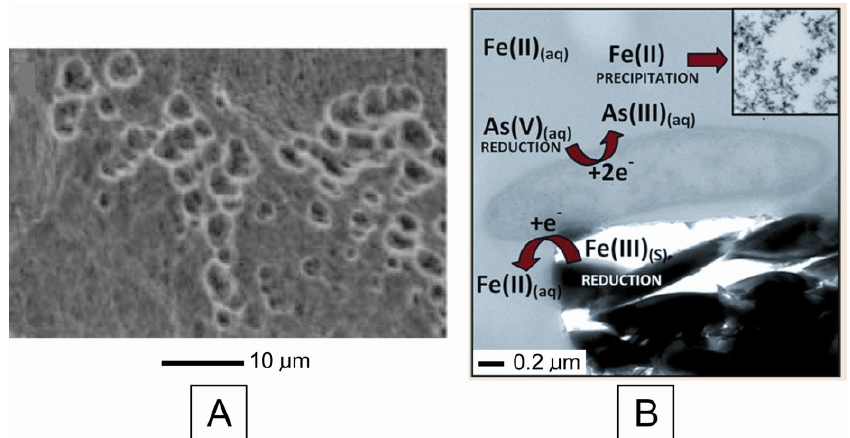
Figure 5. Microbial dissolution of As-bearing minerals found in mine wastes ( A ) Pits in arsenopyrite arising from the oxidative dissolution by Leptospirillum ferrooxidans . Reprinted with permission from Figure 7i in [59], Elsevier. And ( B ) Mechanism of simultaneous reduction of structural Fe(III) and aqueous As(V) during the dissolution of synthetic Pb-As jarosite by Shewanella putrefaciens . Solid Fe(II) phases are formed as a result of this process. Reprinted with permission from [48],